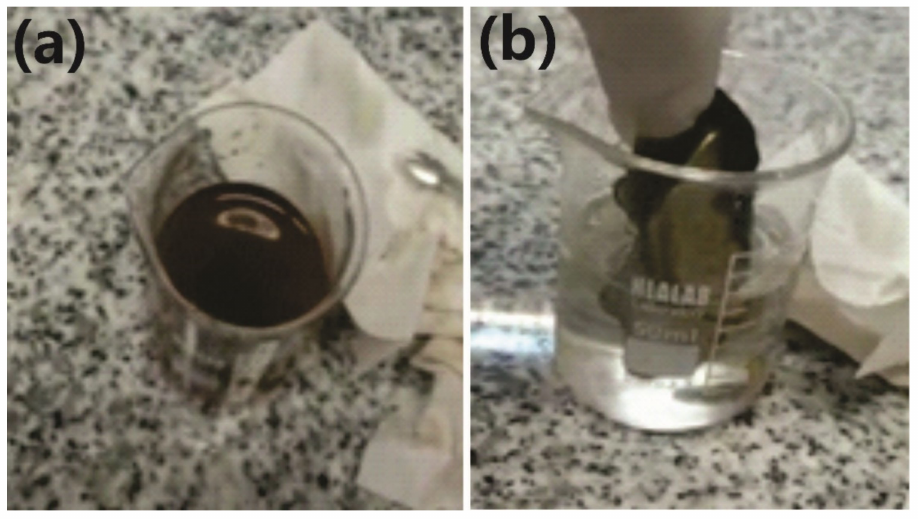
Figure 8. ( a ) Powdered ME suspended in an aqueous solution. ( b ) Aqueous solution before complete removal of FG powder using a permanent